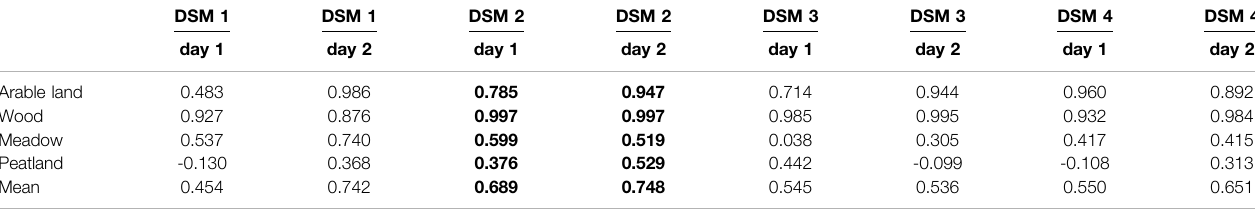
TABLE 2 | Correlation matrix of results obtained on two sampling days 16.08.2021 (day 1) and 30.10.2021 (day